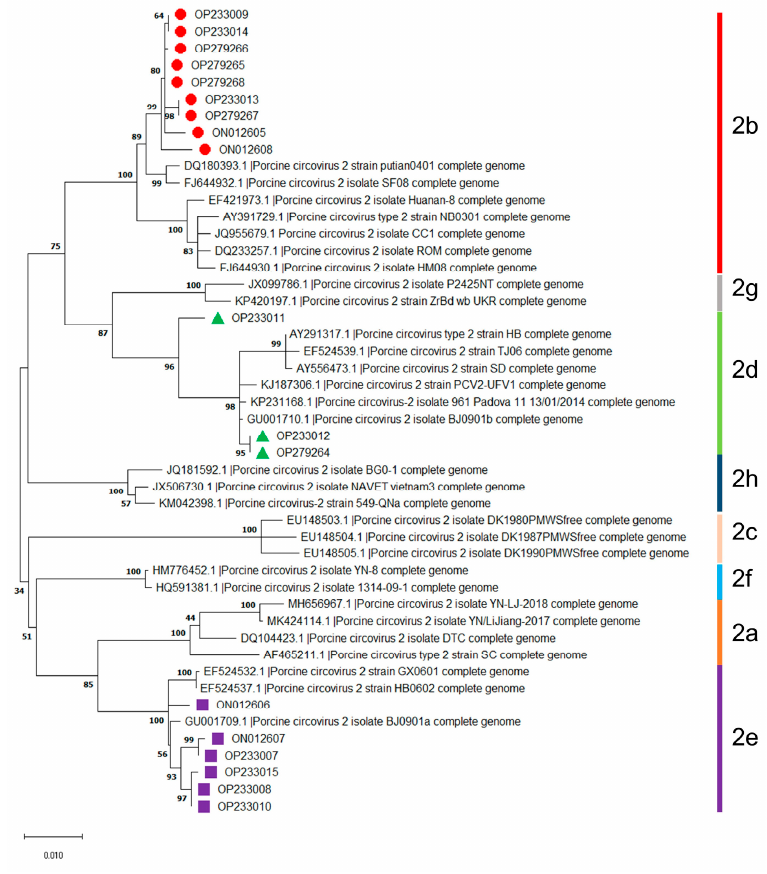
Figure 1. Genotyping of PCV2 isolates obtained during 2016–2021 in Jilin province, China. Information on the thirty available reference sequences of the PCV2 genotypes are summarized in Supplementary Table S2.